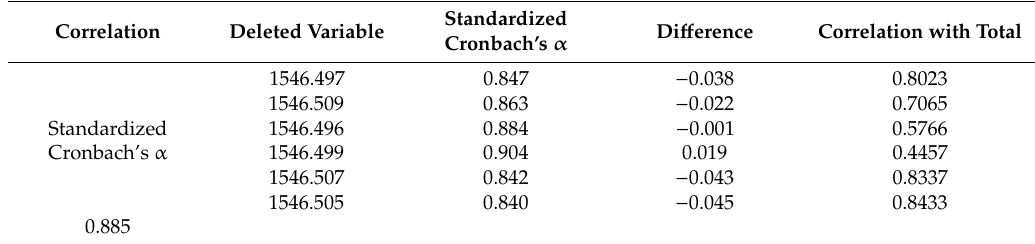
Table A1. Prototype (12-strand braid type) confidence and correlation